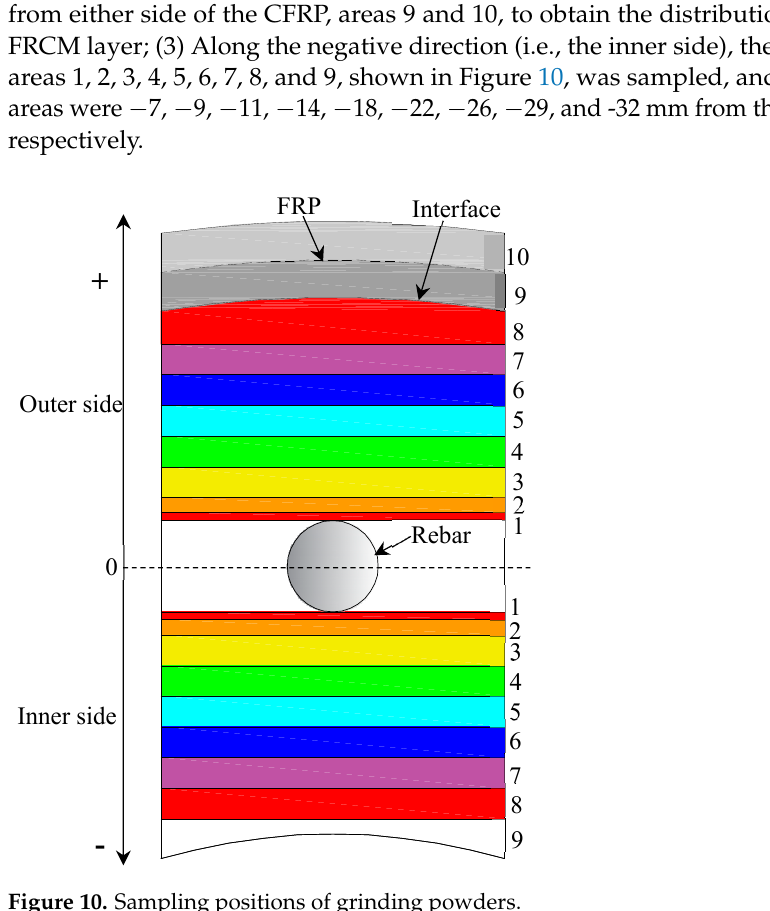
Figure 10. Sampling positions of grinding powders.